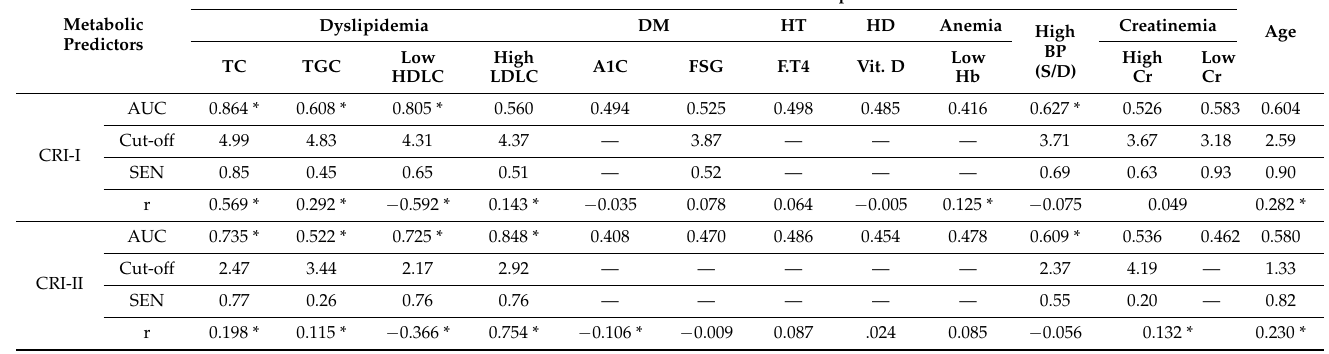
Table 4. AUC–ROC above 0.6, 0.7, and 0.8 were used for cut-off values of CVDs’ susceptibility